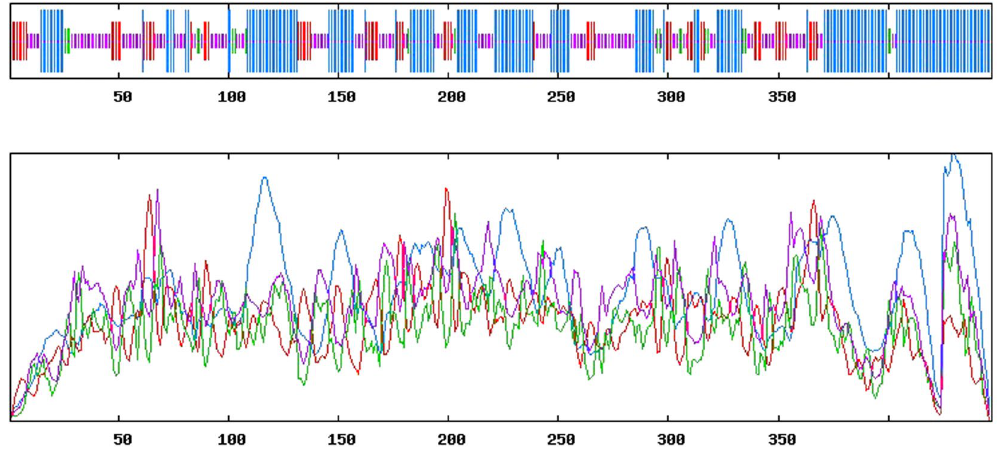
Figure 5. The predicted secondary structure of β - tubulin in S. chinensis . Red lines represent the conserved domain of β -tubulin amino acids.